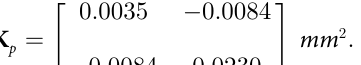
ffiffiffiffiffiffiffiffiffi p 0 : 18 ¼ 2 : 32 , and for ffiffiffiffiffiffiffiffiffi p 0 : 21 ¼ 2 : 16 . The SNR for the industrial case ffiffiffiffiffiffiffiffiffiffiffiffiffiffi p 0 : 0035 ¼ 101 : 42 and for ffiffiffiffiffiffiffiffiffi p 0 : 02 ¼ 32 : 97